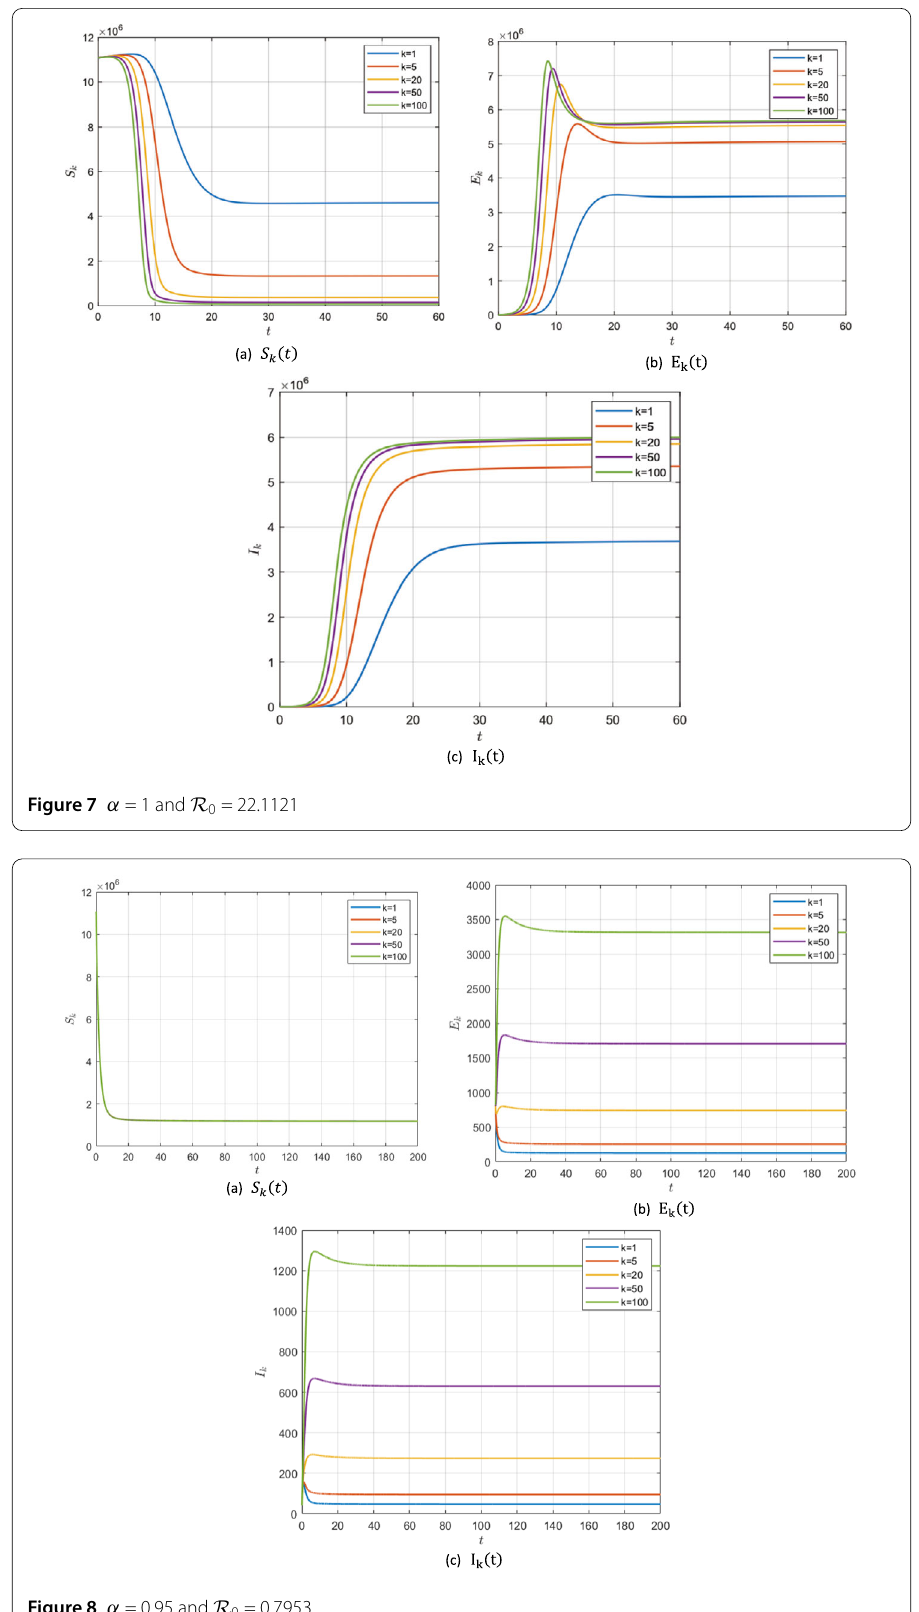
Figure 8 α = 0.95 and R 0 =